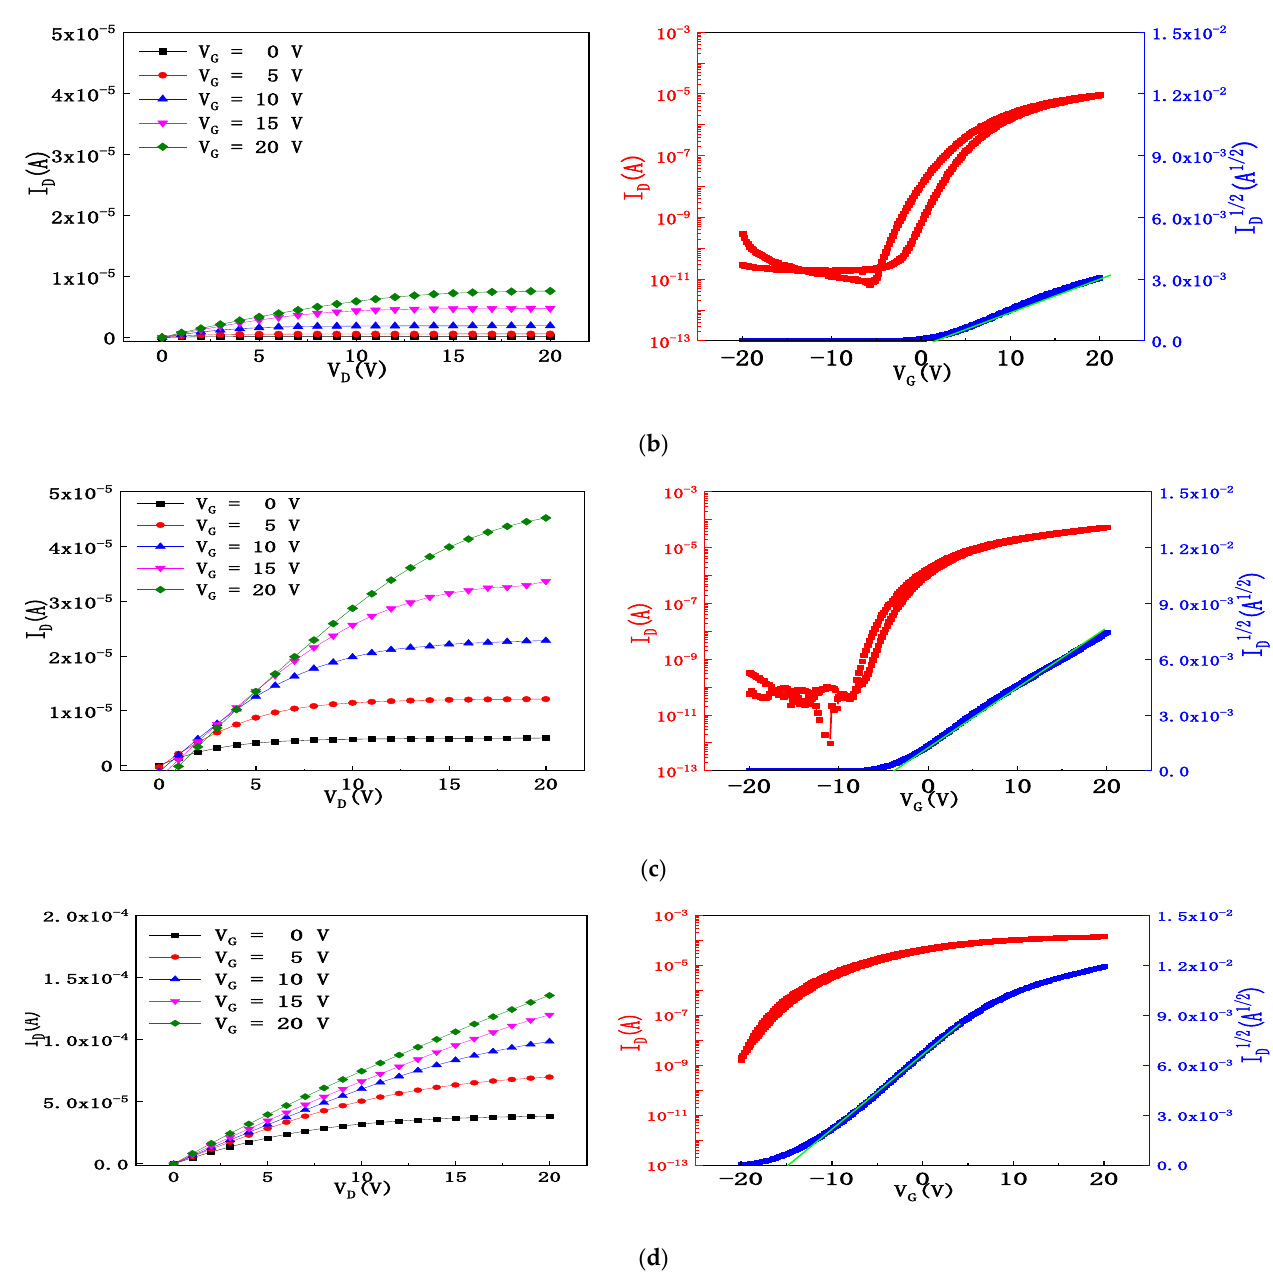
Figure 8. The output and transfer curves of TFT devices at: ( a ) 523 K, ( b ) 573 K, ( c ) 623 K and ( d ) 673 K. Figure 9 shows the main device performances of the TFTs at different annealing temperatures. From Figure 9, it can be analyzed that the on-state current increases gradually, while the off-state current decreases gradually with increasing annealing temperatures, which causes the I on /I off ratio increases in the meanwhile, and it reaches the maximum value of 5.55 × 10 7 after the 623 K